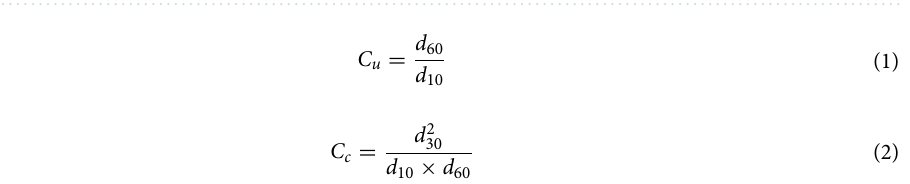
Figure 2. PSD curves and XRD curves of saline–alkali soils in the floodplain of southwestern Shandong Province: ( a ) particle size distribution cures and ( b ) X-ray diffraction